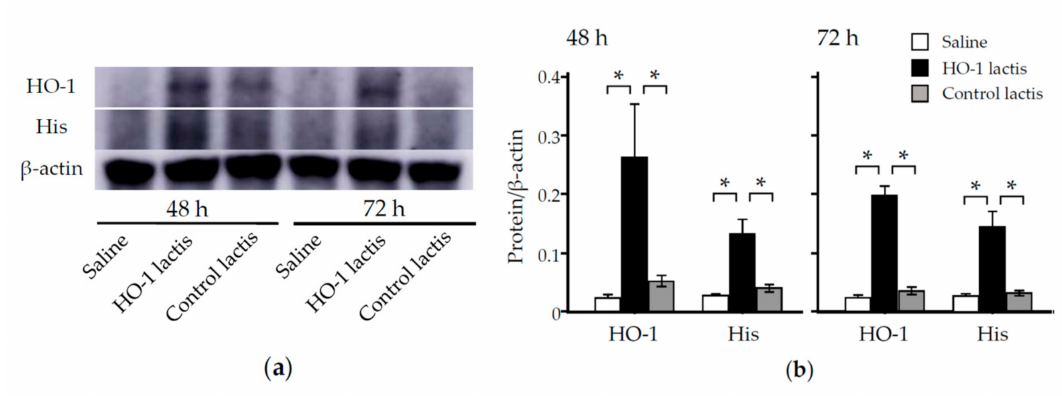
Figure 3. E ff ect of nasal administration of HO-1 lactis on protein expression in the lungs. Analysis of HO-1 lactis-induced protein expression in the lungs 48 and 72 h after nasal administration of 10 × 10 8 cells or saline vehicle. ( a ) The lung homogenates were examined by Western blotting using anti-His tag Ab and anti-HO-1 Ab. ( b ) Bands corresponding to either HO-1 or His tag protein normalized by β -actin were analyzed. Results represent the mean ± SE of 2 independent experiments involving a total of 5 mice / group. *, p < 0.05.